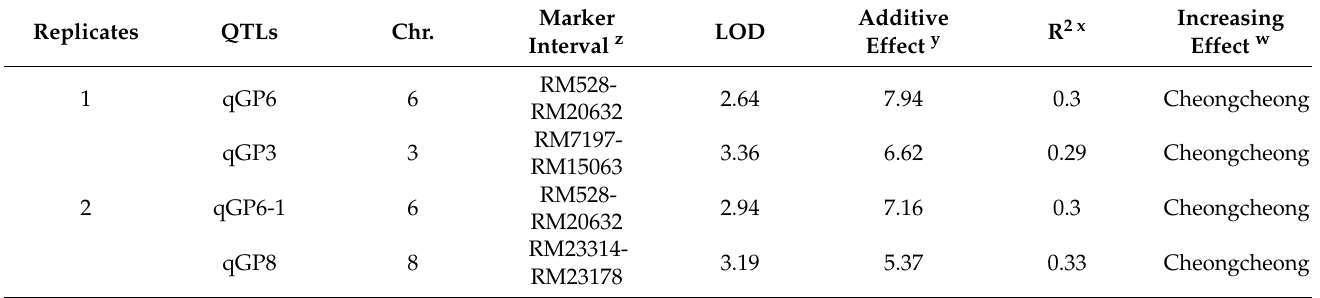
Table 1. QTL associated with the germination percentage in the CNDH